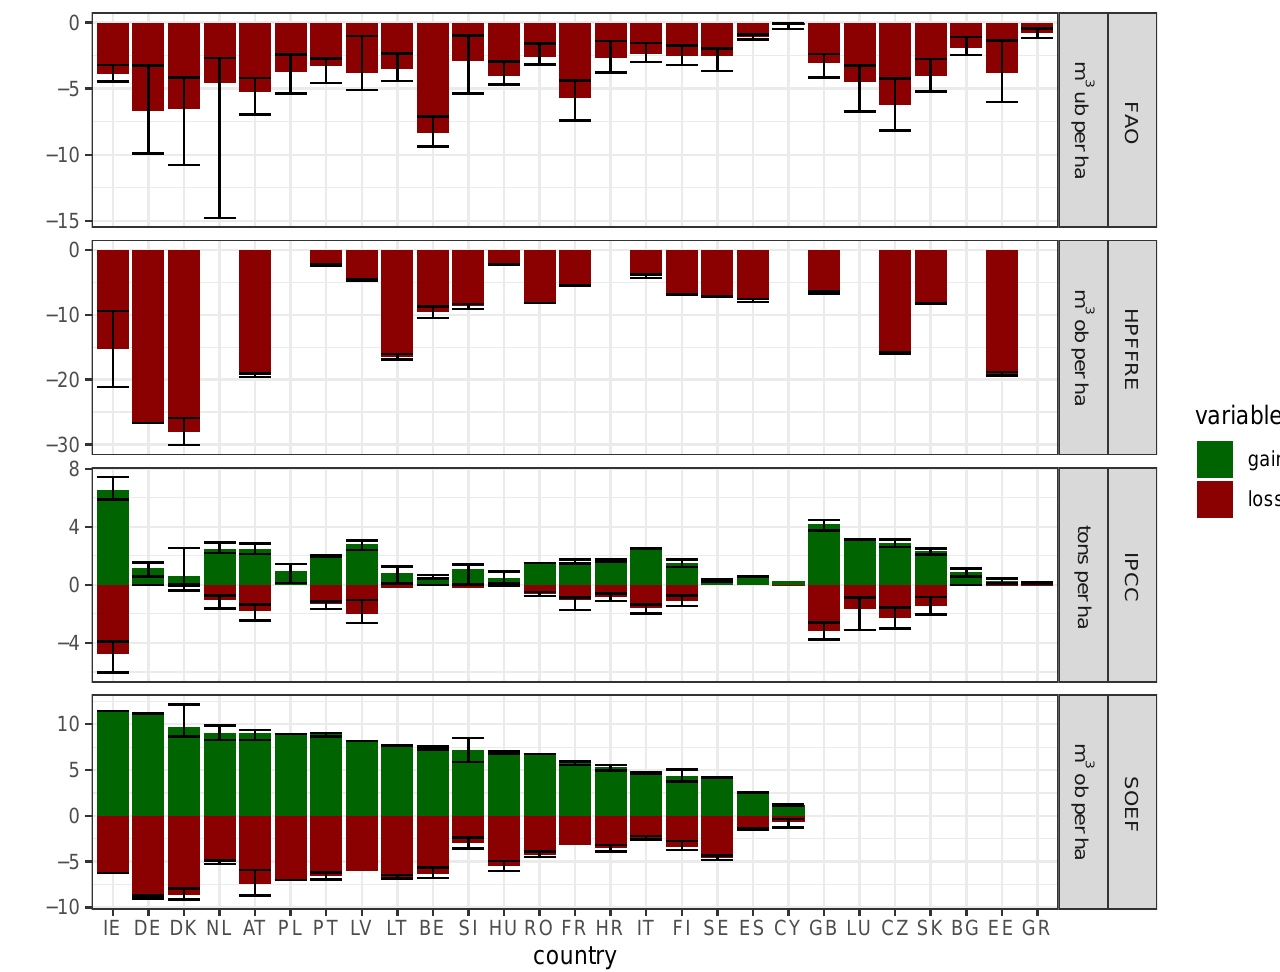
Figure 3. Average gains and losses by country for each source. Error bars represent the minimum and maximum values of the time